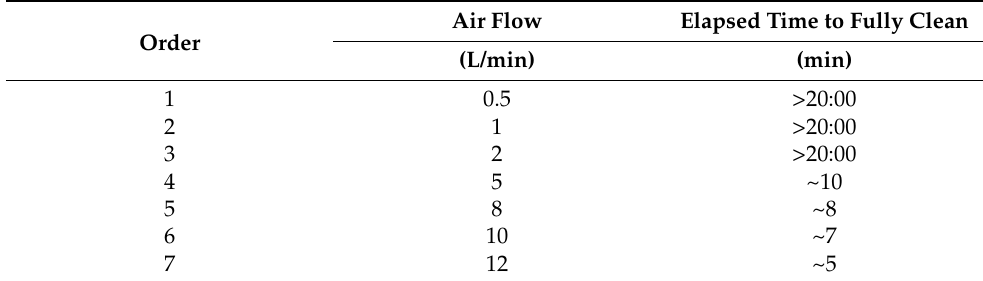
Table 3. Effect of purging flow on the performance of